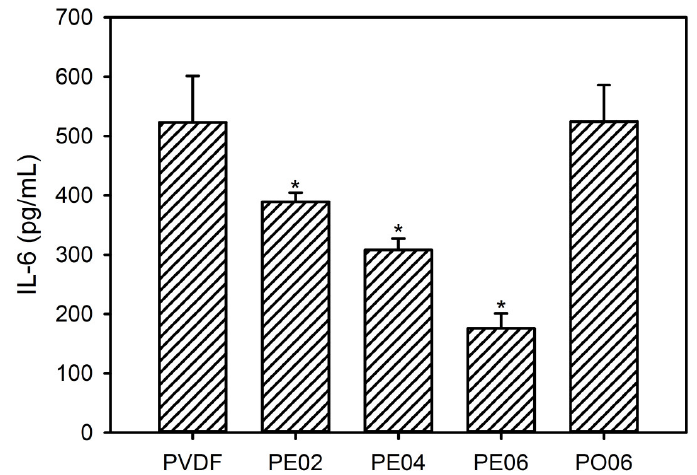
Figure 11. Levels of IL-6 expression by RAW 264.7 cells on the PVDF composite nanofibers ( n = 5). Significant difference from the pure PVDF nanofiber at each time point was denoted as p * ˂ 0.05.